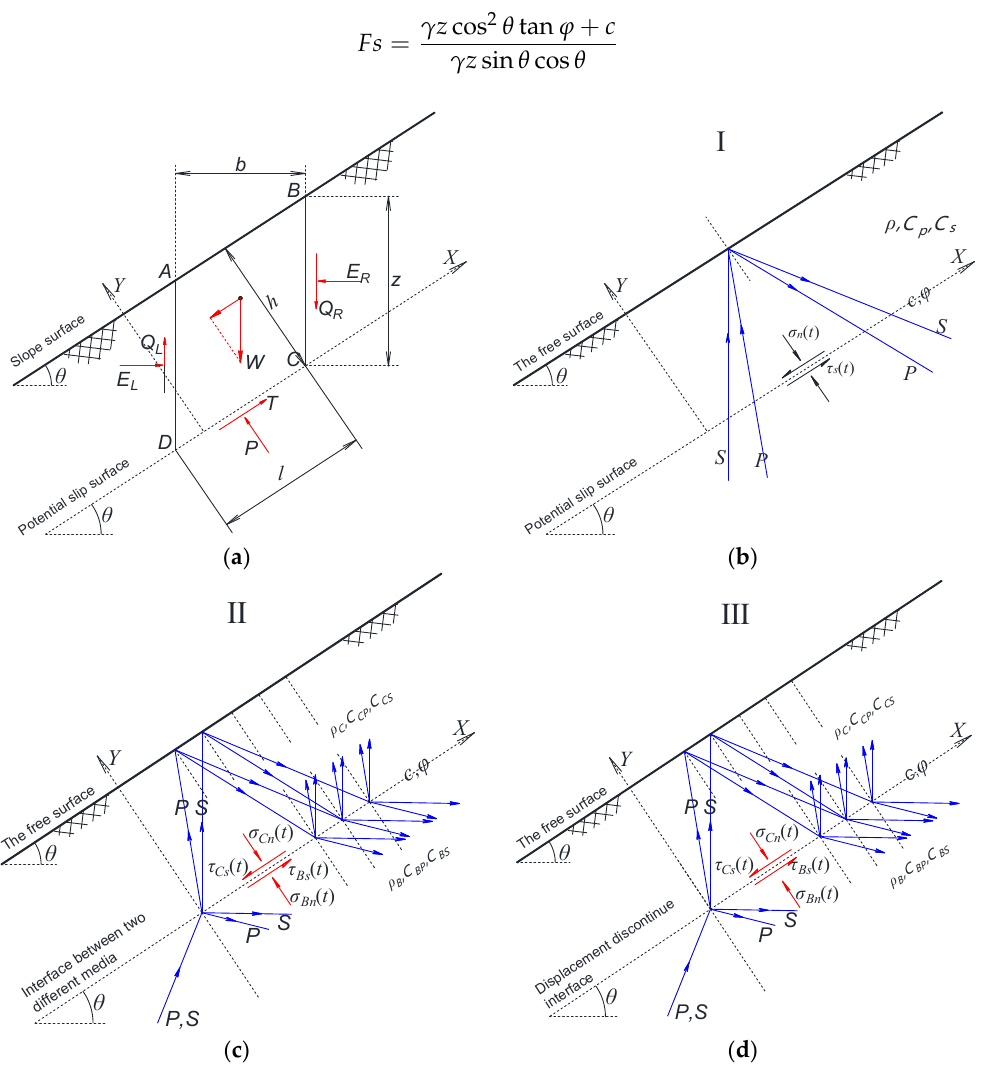
Figure 1. The infinite slope model for instantaneous safety factor analysis: ( a ) static balance; ( b ) model I—continuous geo-material; ( c ) model II—interface between different geo-media; ( d ) model III—displacement discontinuous interface.